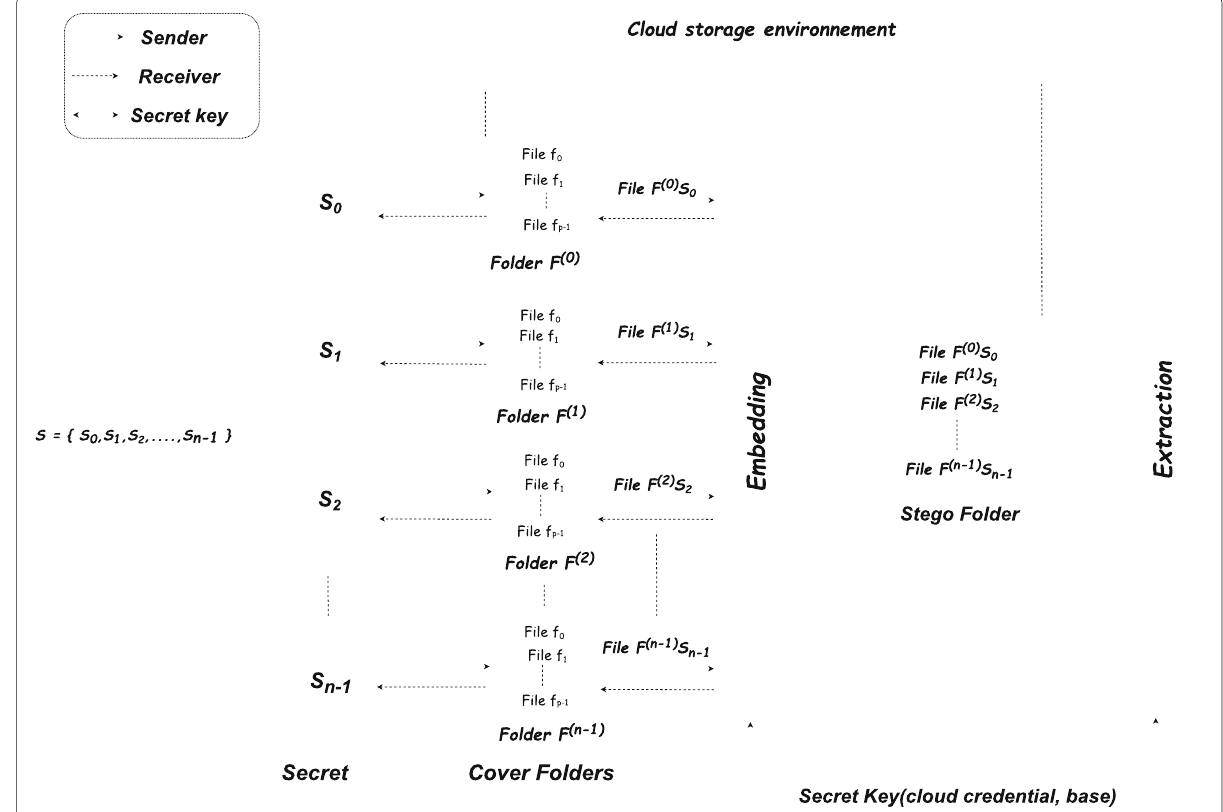
Fig. 1 Overview of a first approach